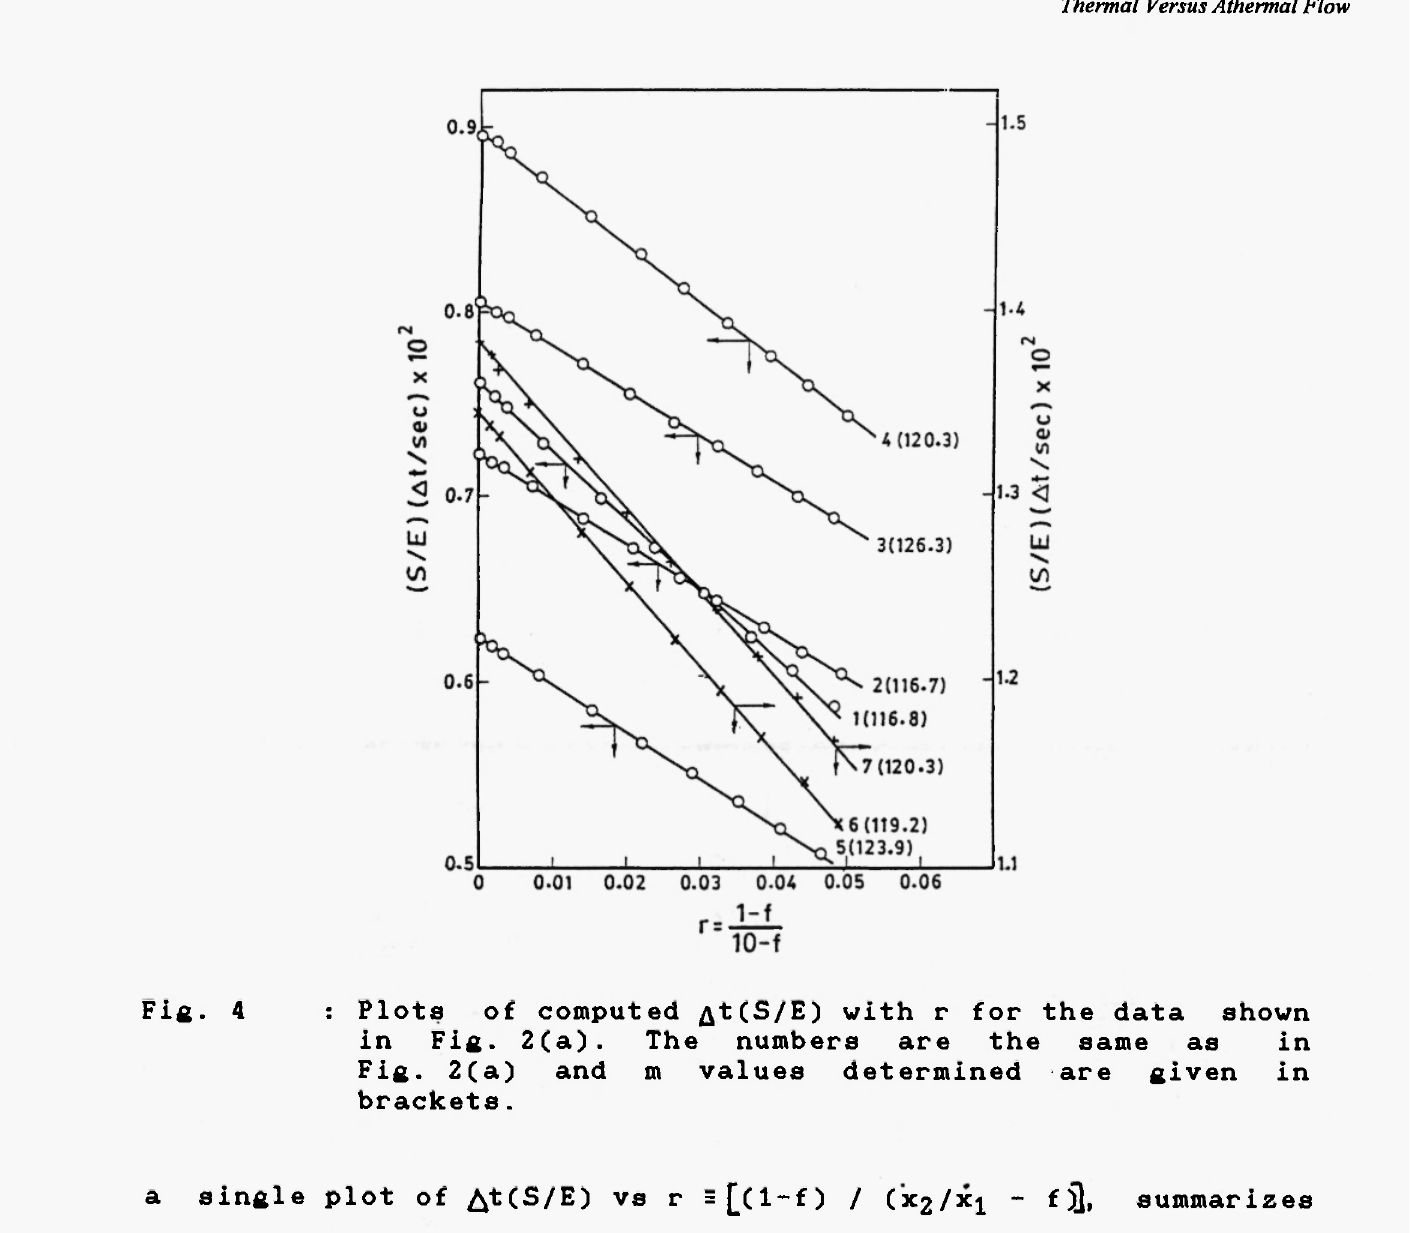
for the ranges of